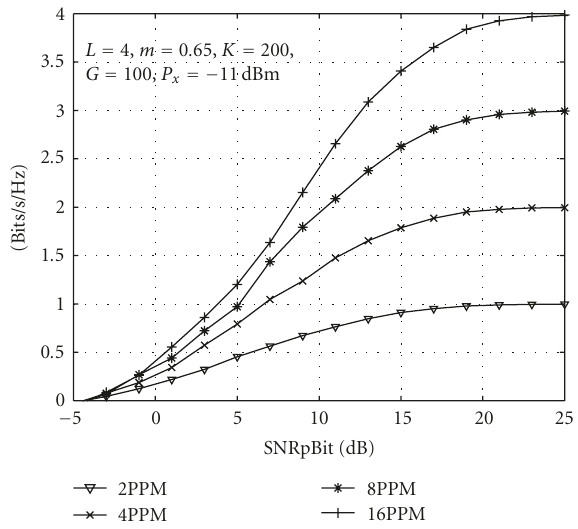
Figure 7: Capacity of a multiple access UWB system with PPM over a multipath fading channel with L = 4, m = 0 . 65, K = 200, G = 100, and P x = − 11